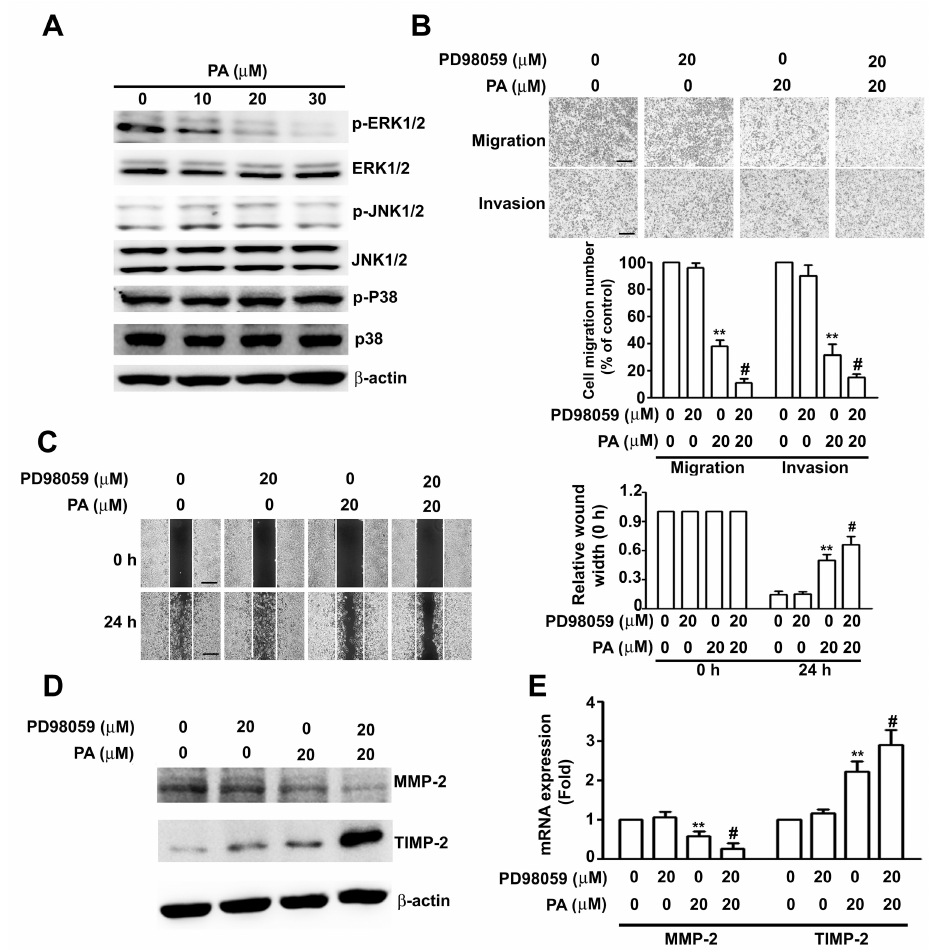
Figure 5. Role ERK1/2 in PA-regulated MMP-2 and TIMP-2 expression in HeLa cells. ( A ) Cells were treated with various concentrations of PA (0 to 30 μ M) for 24 h, then harvested and lysed for measurement target proteins by western blotting; ( B ) cells were treated with or without PA in the absence or presence of PD98059 (specific MEK1/2 inhibitor) for 24 h, followed by measurement of migration and invasion; ( C ) cells were treated as above for 24 h, followed by measurement of relative wound width; ( D , E ) Protein and mRNA expression of MMP-2 and TIMP-2 were measured by western blotting assay and RT-qPCR. Values are means and standard errors of 3 replicates. **, p < 0.01 versus control; #, p < 0.01 versus only PA treatment. Scale bar, 50 μ m.